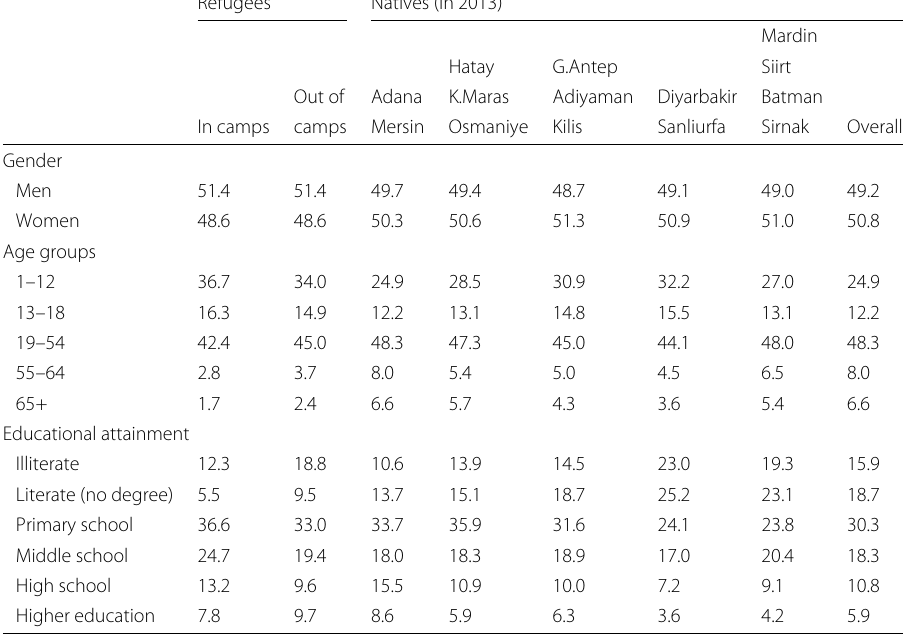
Table 2 Demographic characteristics of refugees vs natives Refugees Natives (in